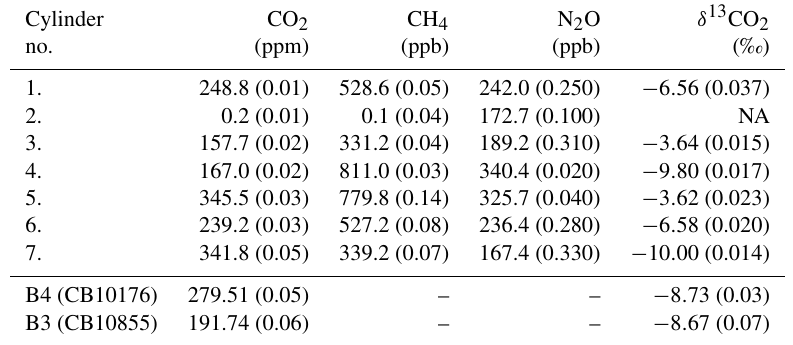
Table 1. Reference values of custom-made standard gases prepared for the calibration of the QCLAS from Bereiter et al. (2020), no. 1–7; and reference air obtained from INSTAAR, no. B4 and B3. The concentrations and isotope ratio values cover the range of expected variations found in air samples from ice cores. The standard no. 2 is matrix air (free of CO 2 and CH 4 ) that was used to generate the various standard mixtures by adding different amounts of trace gases. The uncertainty of the values is given in parentheses as 1 σ